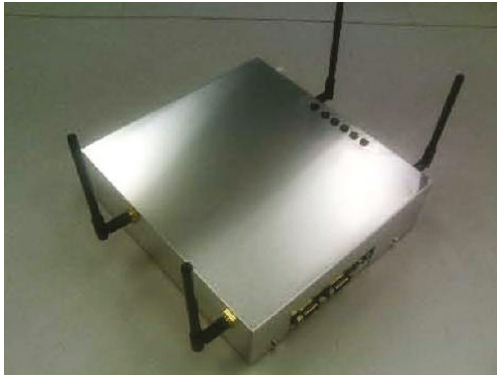
Figure 10: The ad-hoc wireless relay